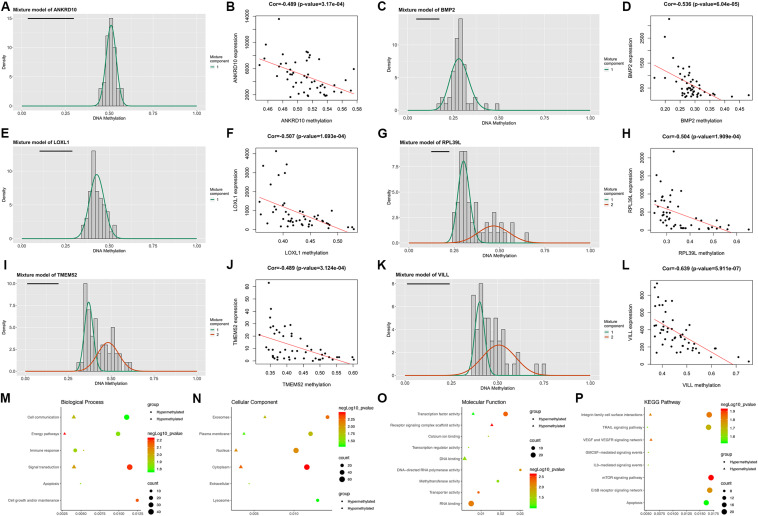
Overview of the DNA methylation-driven genes (MDGs) identified by MethylMix analysis. (A,C,E,G,I,K) The β mixture models of the representative six MDGs. The distribution of methylation status among GBM samples is shown by the histogram. The distribution of methylation status among normal samples is shown by the black line. (B,D,F,H,J,L) Correlation plots of the methylation and expression levels of the representative six MDGs. Biological process (M), cellular component (N), and molecular function (O) terms and KEGG pathways (P) enriched in the 199 MDGs.